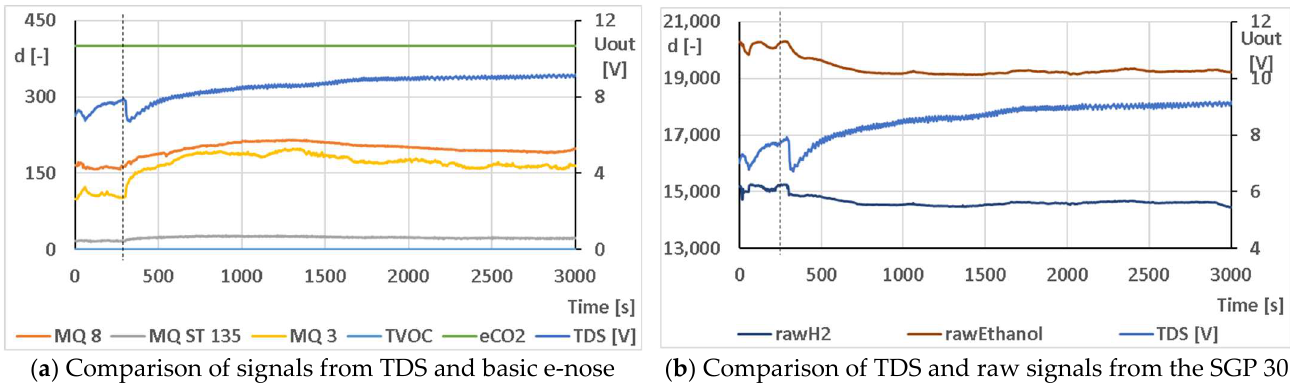
Figure 9. Example of comparison of output signals from the experimental e-nose and TDS for testing the budding of the addition of 0.5 g dried yeast (Thymos, spol. s r.o., Vel’k á Lomnica, Slovakia) in sugar solution (70 g/L). The moment when yeast was added into the sugar solution is marked by the dashed